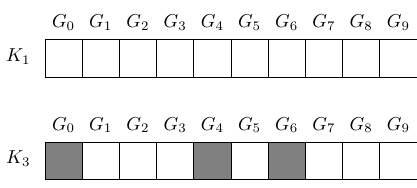
Figure 3. Graphical representation of the mutation procedure on the example with M = 10 and N = 3 ( K 1 - parent chromosome, K 3 - child chromosome, G -